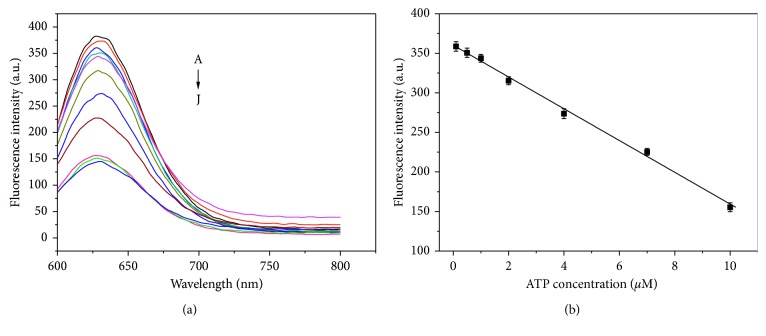
(a) Fluorescence spectra of MB-Ag nanoclusters for ATP detection. The ATP concentrations are (from A to J) 0, 0.01, 0.1, 0.5, 1, 4, 7, 10, 30, and 50 μmol·L−1. (b) Linear relationship between ATP concentration and fluorescence intensity. Conditions: 1 μmol·L−1 DNA; 6 μmol·L−1 Ag; 6 μmol·L−1 NaBH4; 10 U T4 DNA ligase; and 50 mmol·L−1 Tris buffer (pH 7.4).